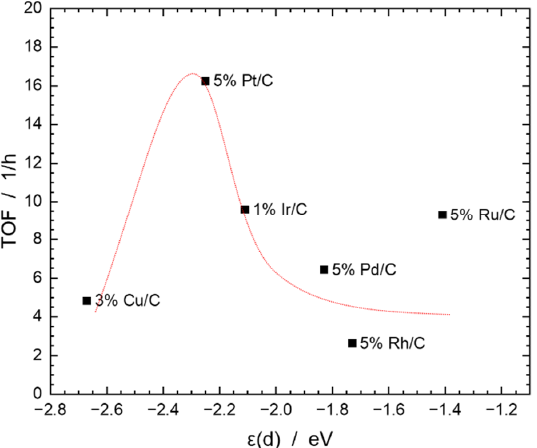
13 of 19 Figure 8. c(i-Butanol) plotted against the reaction time for all catalysts. t(Reaction) = 4 h, T = 150 °C, N = 1000 RPM, V = 70 mL, and m(catalyst) = 0.1 g. ( a ) Overview of the entire reaction time and ( b ) enlarged for the heating-up period. The dotted line marks the point at which 150 °C was reached. For Pt/C, we were able to prove a deposition of carbonaceous matter on the catalyst by pulsing the catalyst with ethanol under ultra-high vacuum (UHV) conditions, as re- cently published [32]. Taking into account the pressure gap, we anticipate coking pro- cesses to have been a reason for the catalyst deactivation. Clarifying these deactivation processes is a goal of future research, especially as Ru/C, Rh/C, and Cu/C did not exhibit these deactivation processes. In the beginning, for Ru/C, a STY of 1.31 ± 0.23 mmol·h −1 g cat−1 at 1 h was measured. Taking into account the error limit, after 4 h, the STY was equal (1.57 ± 0.04 mmol·h −1 g cat−1 ) and could therefore be regarded as constant. As the reaction solution of the Ru/C catalyst had a slight brown color, we suspected that the catalyst was prone to leaching. ICP-OES measurements of the filtered reaction solution showed clear evidence that some amount of the catalyst dissolved into the reaction solution. The catalysts of Cu and Rh showed an initiation phase in which no i-butanol was detected by gas chromatog- raphy–mass spectrometry (GC-MS). After 2 h, i-butanol could be detected for all catalysts. The reaction rates followed a similar trend for all of these catalysts, as they possessed a more or less stable reaction rate with respect to i-butanol. In order to correlate the chemical properties of the metals with their electronic struc- tures, we correlated the TOF to their d-band centers. Figure 9 displays these results plotted against the d-band centers of the metals as calculated by Hammer and Nørskov [45] and shows that the TOF of the metals plotted against the d-band centers results in a volcano plot. Platinum represents the optimum in this curve. The activity of the metals for i-buta-